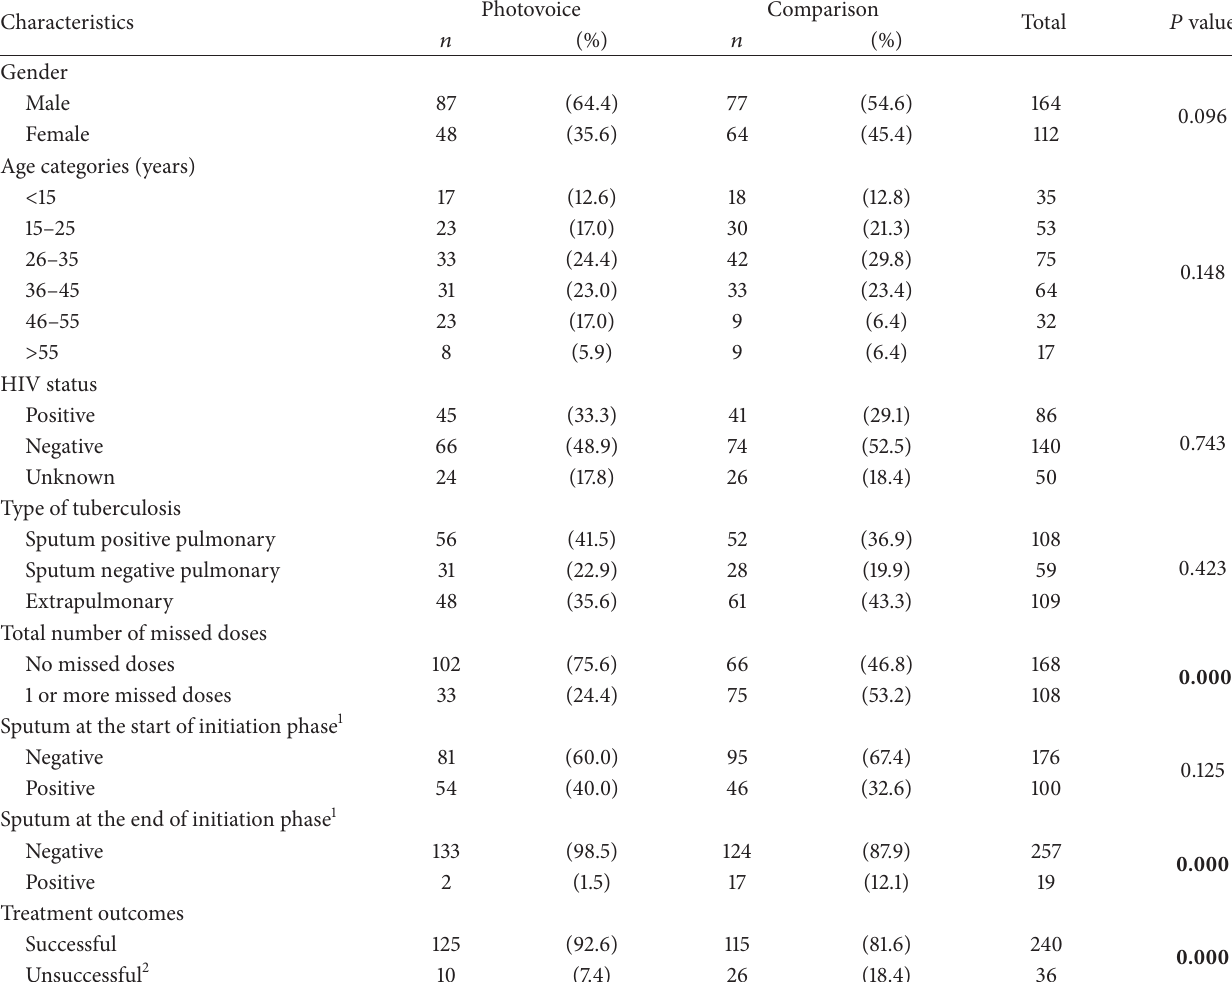
Table 1: Demographic, risk, and treatment outcomes of TB patients who viewed the Photovoice video and comparison group who did not, Pune,